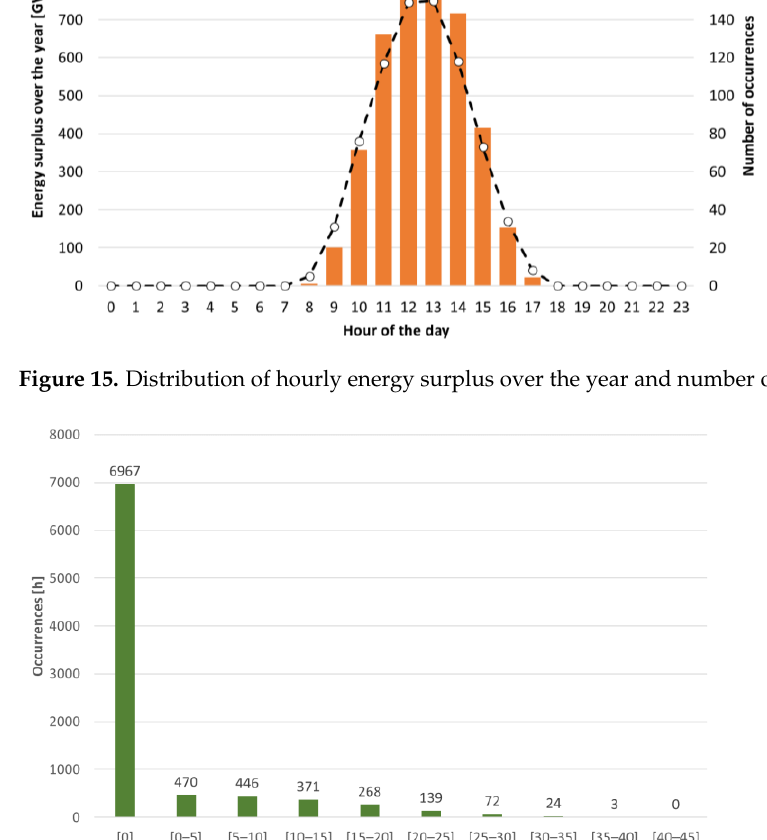
Figure 17. Distribution of hourly energy surplus over the year and number of occurrences in Case 2. 5. Extended Analysis The previous analysis may be extended to different combinations of wind and pho- tovoltaic penetration. In particular, a wind and a photovoltaic energy generation up to four times the current one was considered ( 𝑚 = 1 ÷ 4; 𝑛 = 1 ÷ 4) . The results are reported in Figure 18 in terms of: •